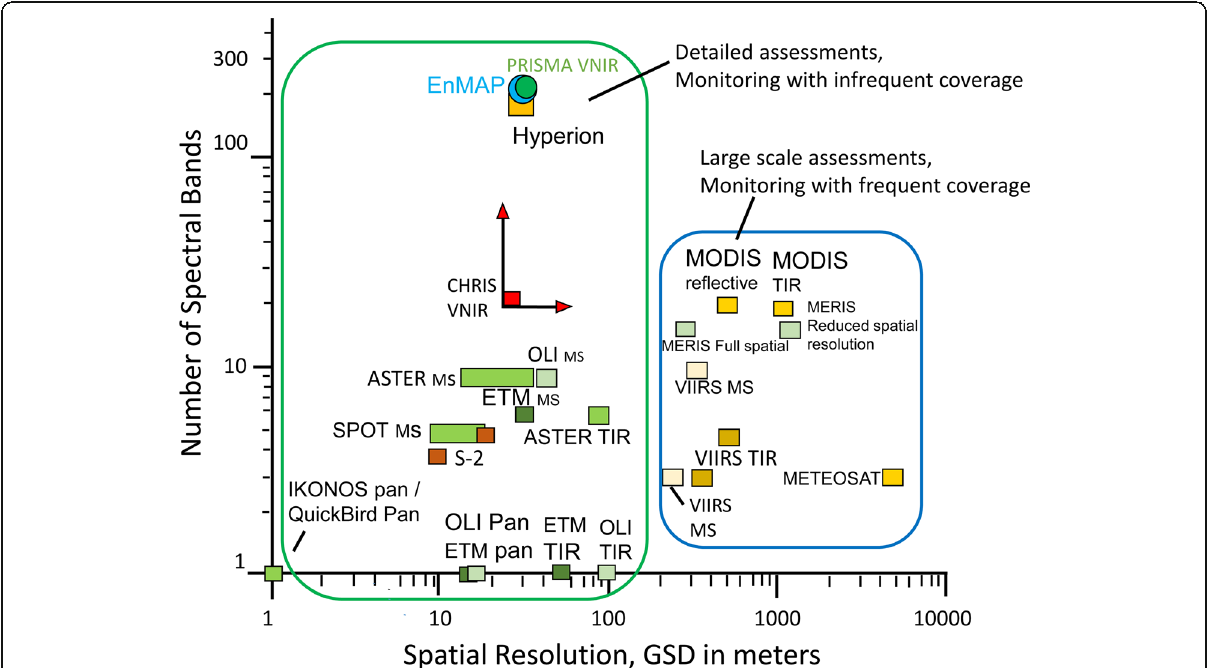
Fig. 16 Comparison of EnMAP spectral bands and pixel (ground spatial) resolution with other optical imagers. Image credit: OHB/Kayser-Threde, GFZ, from: https://earth.esa.int/web/